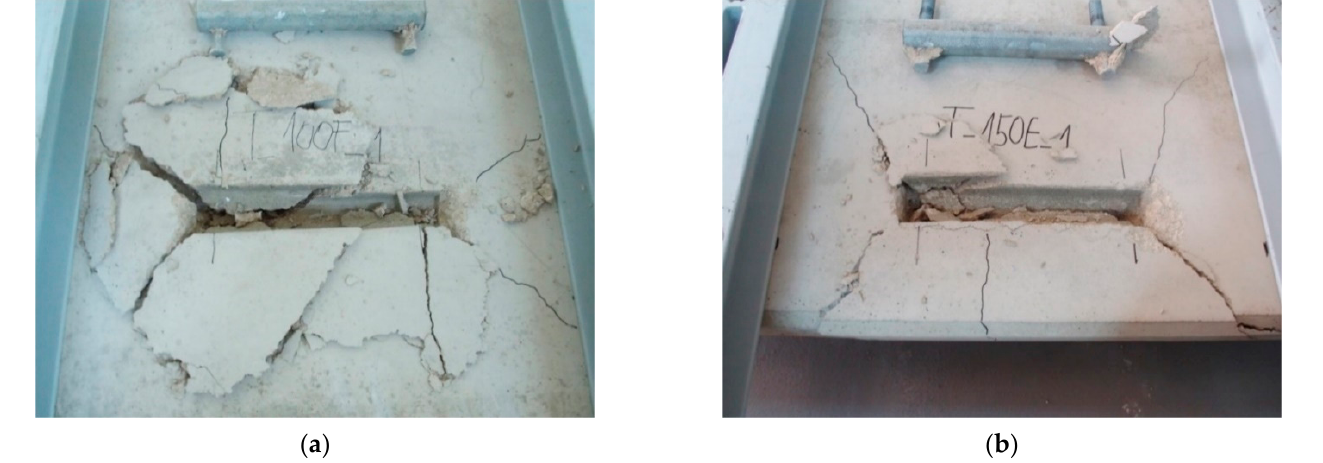
Figure 11. Breakout patterns: ( a ) in-field installation— h = 100 mm; ( b ) installation near the edge— c 1 = 150 mm.